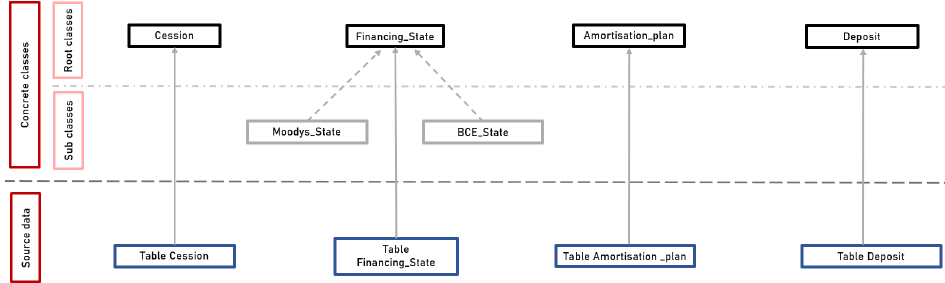
Figure 9. Mapping Layer and Mapping Relationships defined for the running